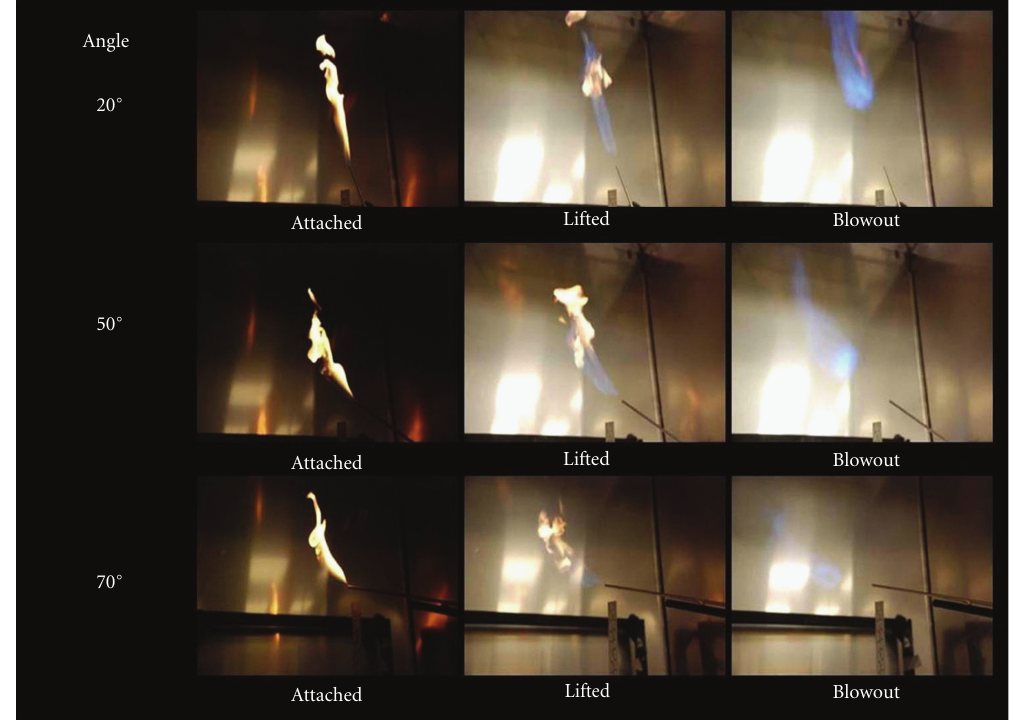
Figure 3: Flame states at 0.4m/s coflow.